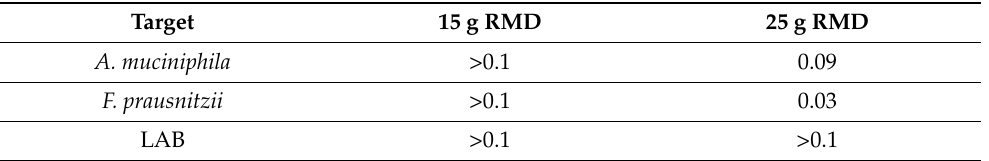
Table 2. p -values for exploratory analysis of effects of RMD on A. muciniphila , F. prausnitzii and LAB in individuals with low baseline log 10 counts of respective